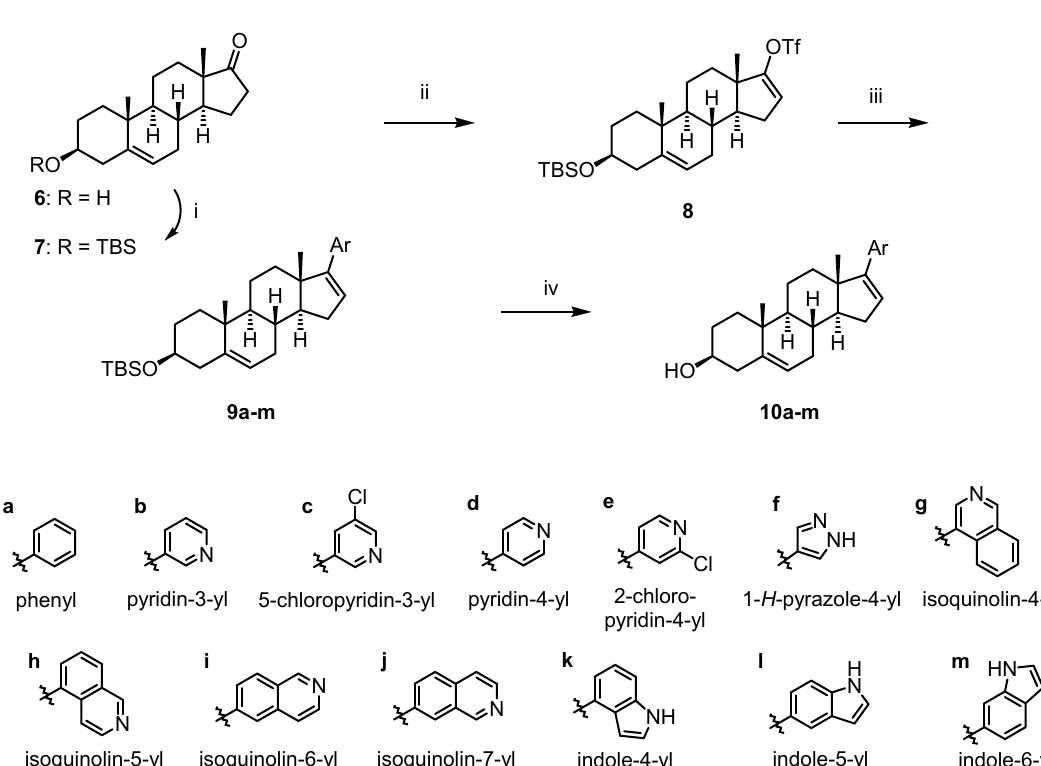
Table 1. Biological evaluation of compounds 10a–10m